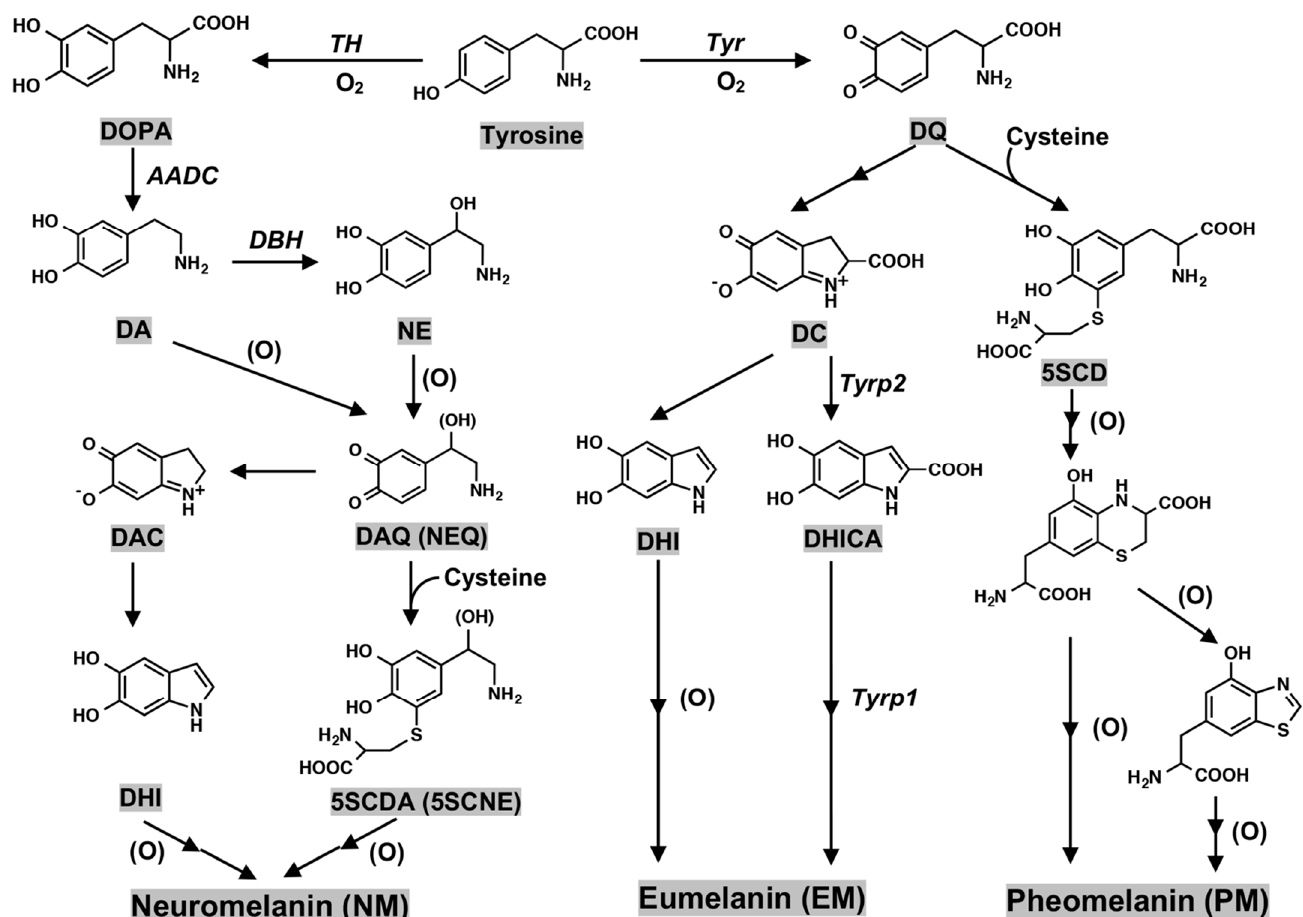
Figure 4. Biosynthesis pathway leading eumelanin, pheomelanin, and neuromelanin production. (DAQ) DAquinone; (NEQ) NEquinone; (DAC) DAchrome; (DHI) 5,6-dihydroxyindole; (5 S CDA) 5- S -cysteinyldopamine; (5 S CNE) 5- S -cysteinylnorepinephrine; (DQ) DOPAquinone; (DC) DOPAchrome; (DHICA) 5,6-dihydroxyindole-2-carboxylic acid; (5 S CD) 5- S -cysteiyldopa; (Tyr) tyrosinase; (Tyrp2) tyrosinase-related protein 2; (Tyrp1) tyrosinase-related protein 1. Enzyme names are shown in italic for the sake of clarity. (O) represents the oxidants.